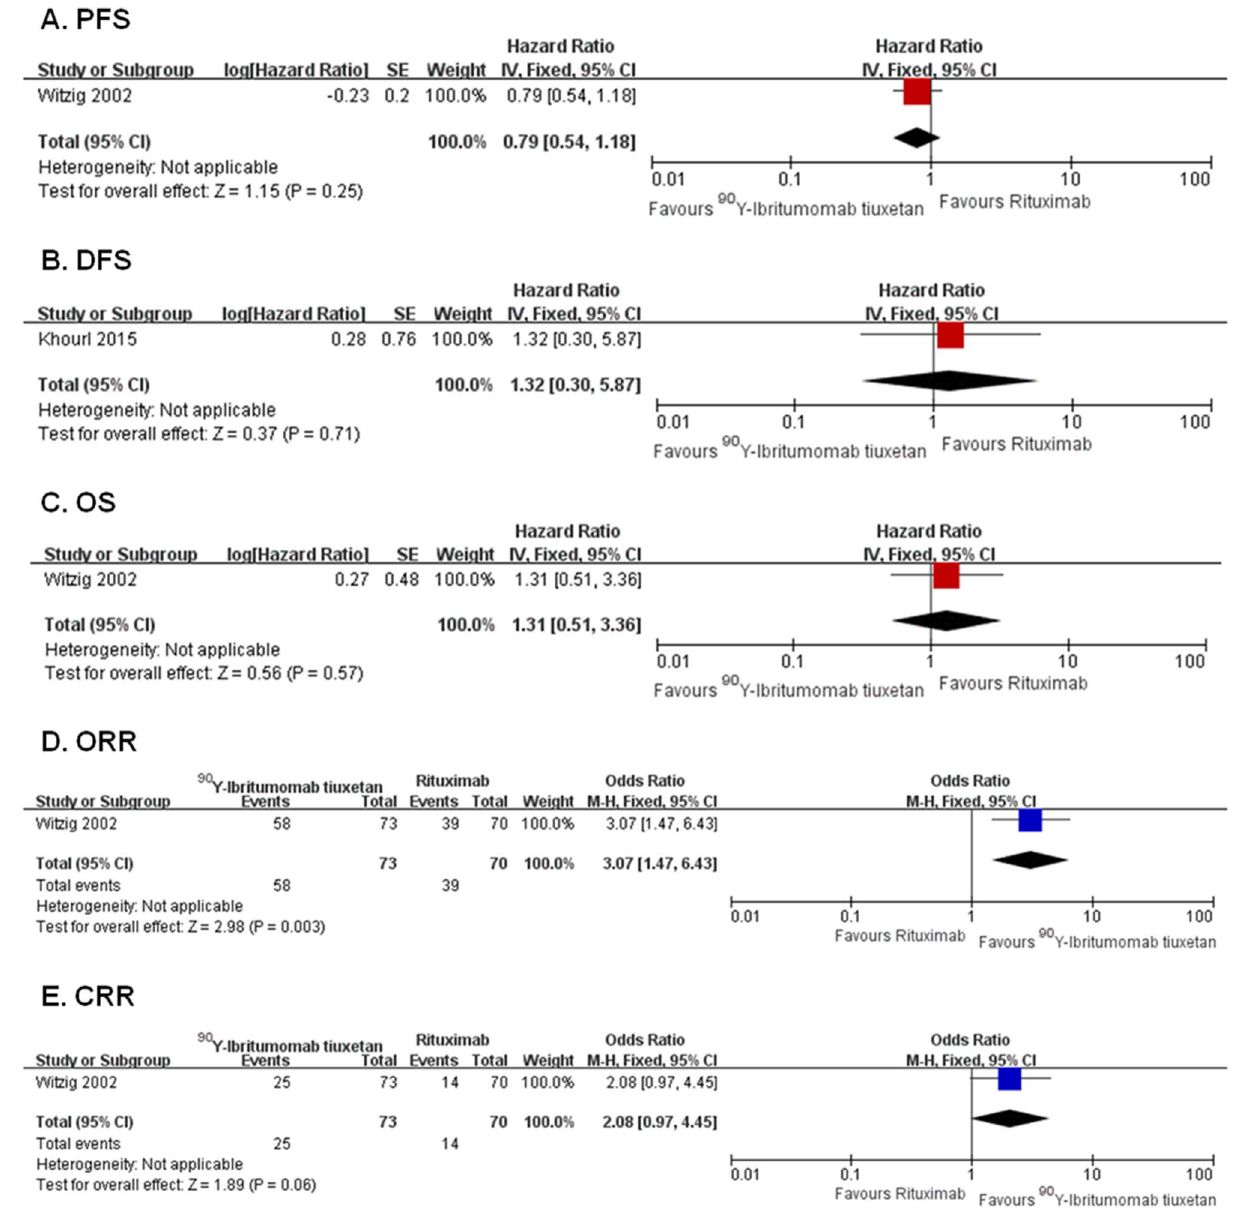
Figure 5. Forest plots of 90 Y-ibritumomab tiuxetan versus rituximab. Forest plot of the meta-analysis that estimating the ORs and HRs with their corresponding 95% CIs for the 131 I-tositumomab group, compared with that in the rituximab group. PFS progression-free survival, DFS disease-free survival, OS overall survival, ORR overall response rate, CRR complete response rate, HRs hazard ratios, ORs odds ratios, 95% CI 95% confidence